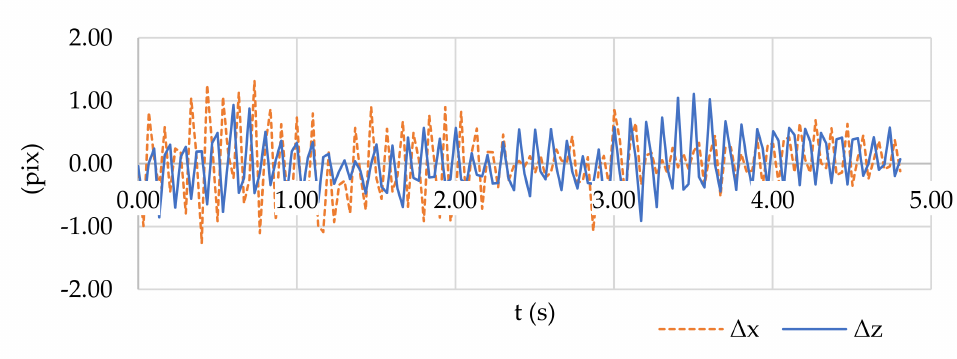
Figure 7. Changes in image coordinates x and z for GCP 5 recorded from camera 1 (coordinates of the coded targets were measured with subpixel accuracy in PhotoModeler software). The vibrations fall within 1 pixel